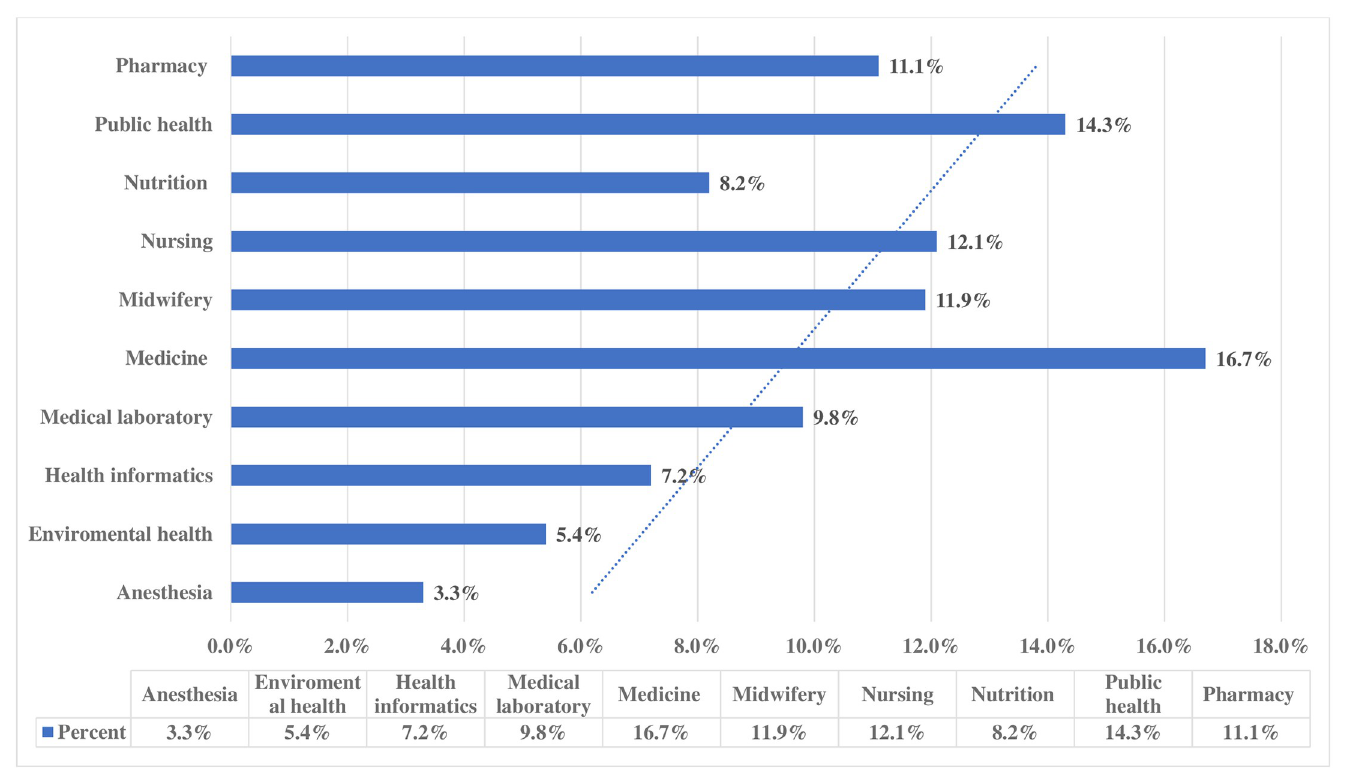
Fig 2. Showing department among DMU SMCHS students on mental distress North West, Ethiopia, 2021 (N = 461).